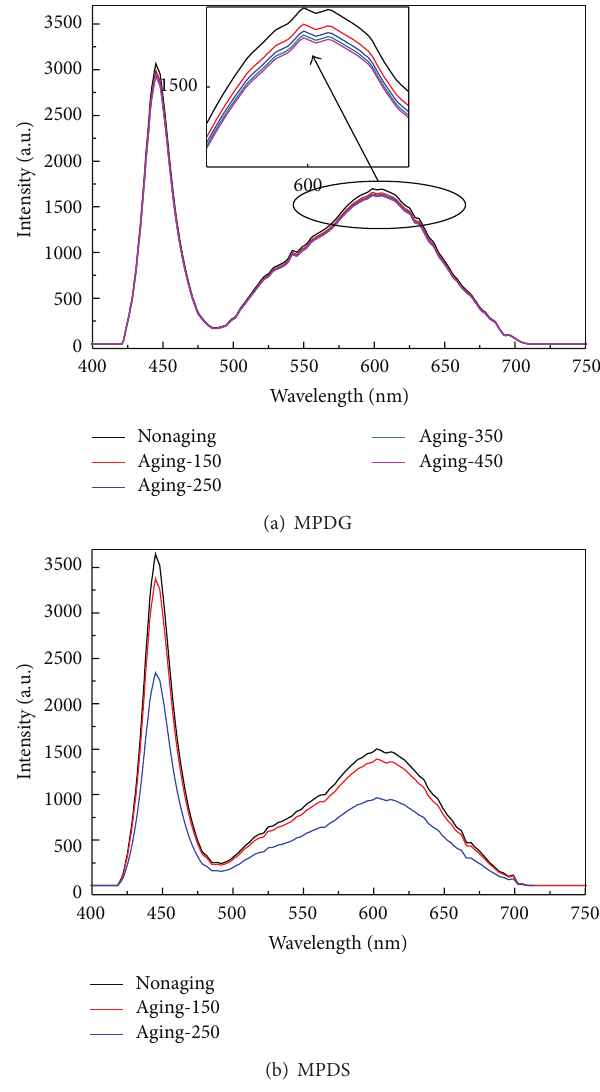
Figure 5: Emission spectrum versus aging time for PC-WLEDs of MPDG and MPDS samples at different